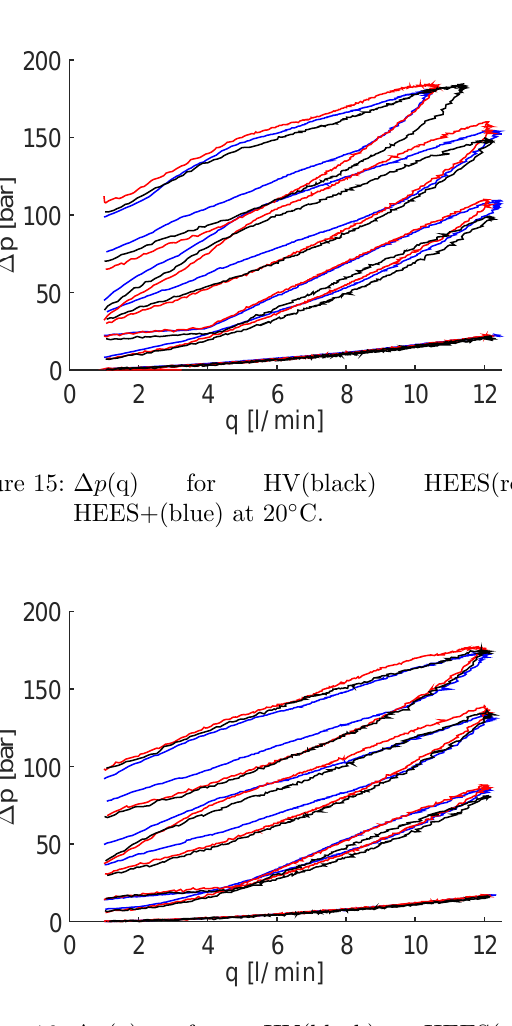
Figure 16: ∆ p (q) for HV(black) HEES(red) HEES+(blue) at 40 ◦ C.